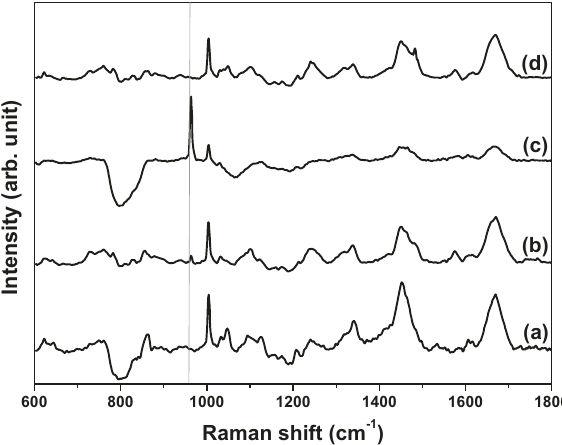
Fig. 5 Stack of averaged processed Confocal-Raman spectra ( n = 36) from the nuclei of three random single U-2 OS cells on quartz sub- strates. Cells derived from TI-HA-ANN over 28 days in culture under standard conditions; a day 7, b day 14, c day 21, and d day 28. Grey solid line shows Raman peak at ~963 cm − 1 at day 14 (weak) and 21